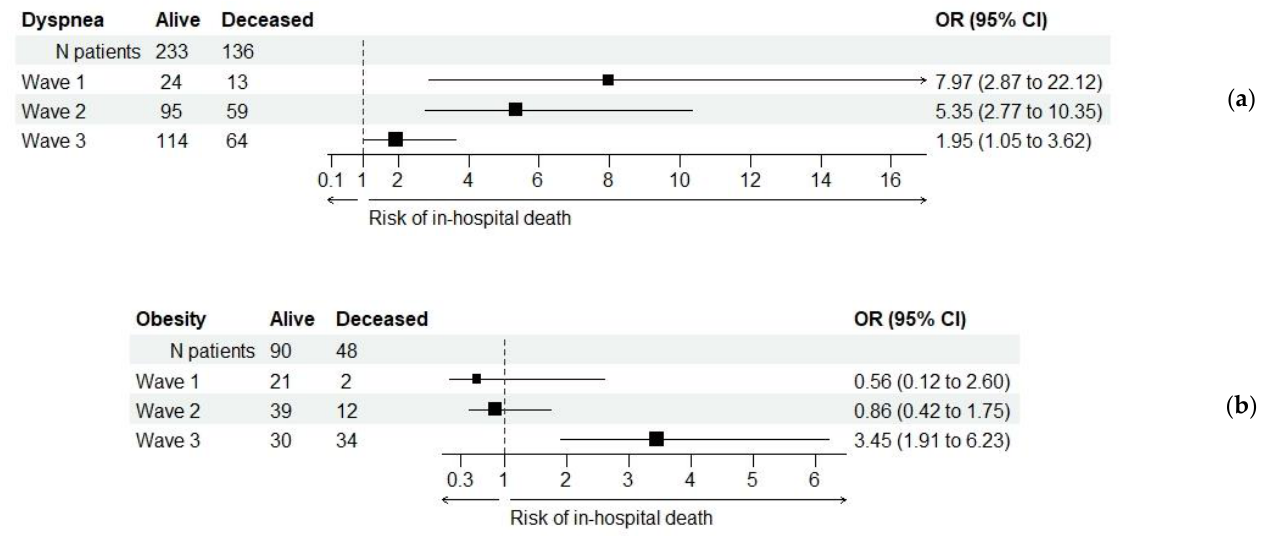
Figure 4. Odds ratio (OR) values for in-hospital deaths in relation to dyspnea ( a ) and obesity ( b ). The risk of in-hospital death associated with dyspnea was significantly decreased in wave 3 (Breslow–Day